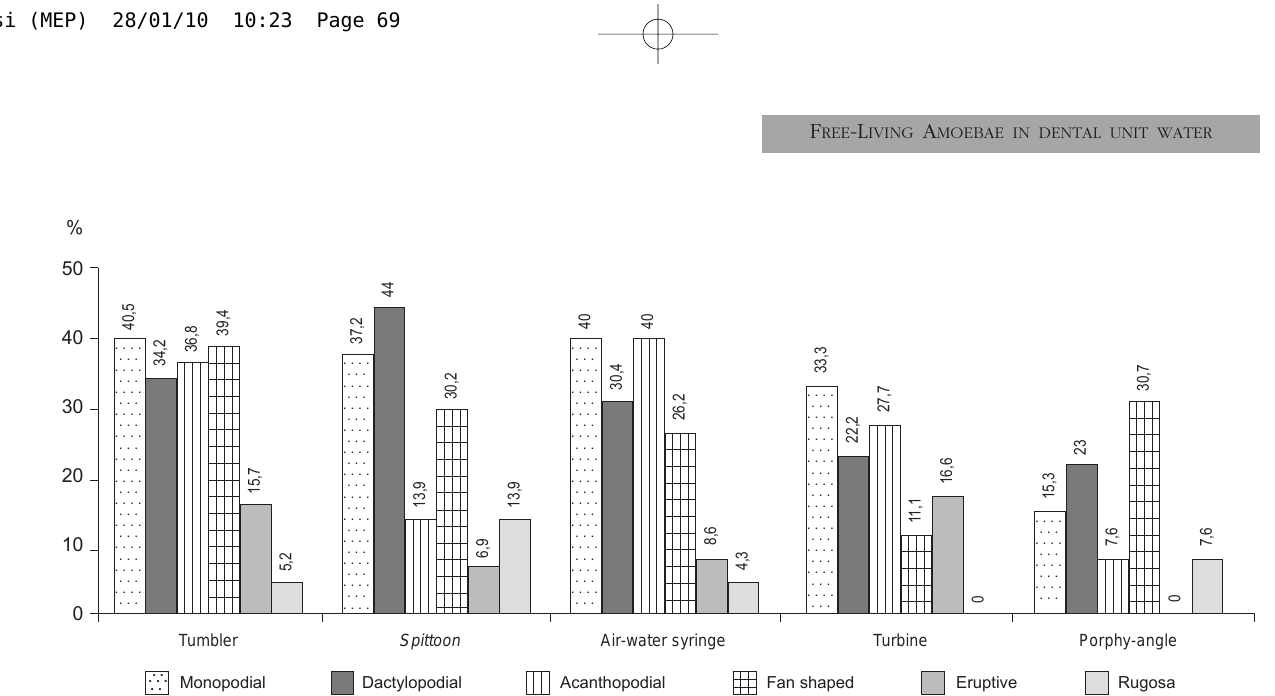
Fig. 2. – Frequency of FLA morphotypes in the different points of